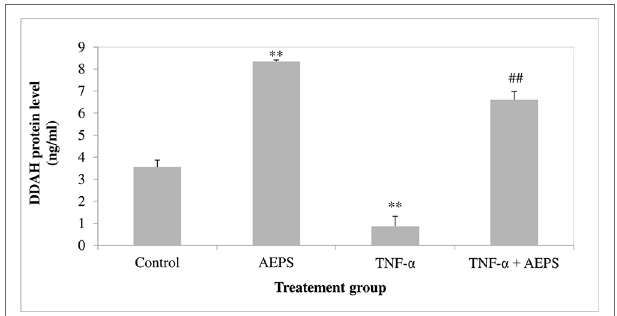
FIGURE 4 | DDAH1 protein level in human umbilical vein endothelial cells (HUVEC). Data shown as mean ± SEM, n = 6 [** P < 0.01 compared with the control group, ## P < 0.01 compared with the tumor necrosis factor (TNF)- α group].